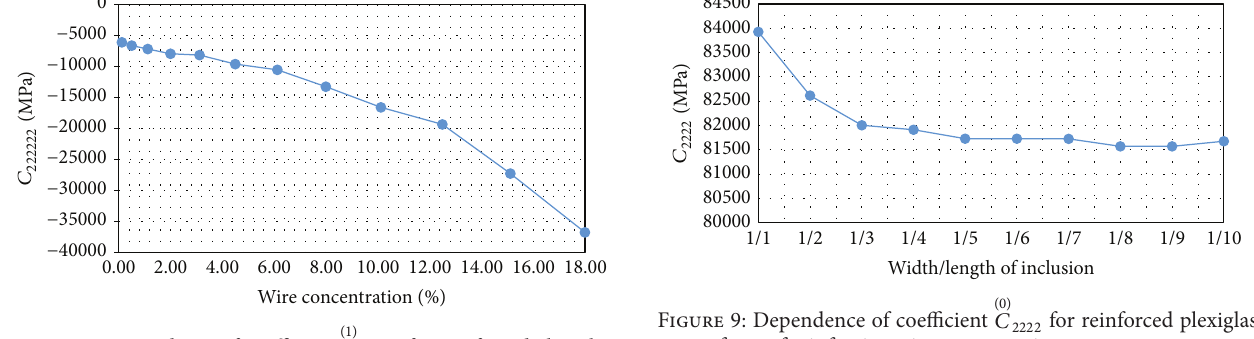
(1) 𝐶 222222 for reinforced plexiglas